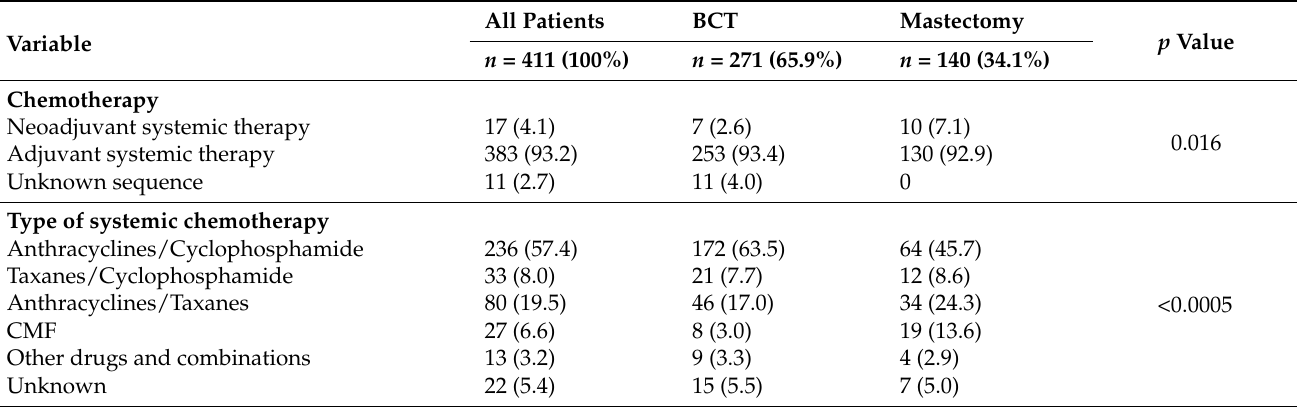
Table 2. Type and sequence of systemic